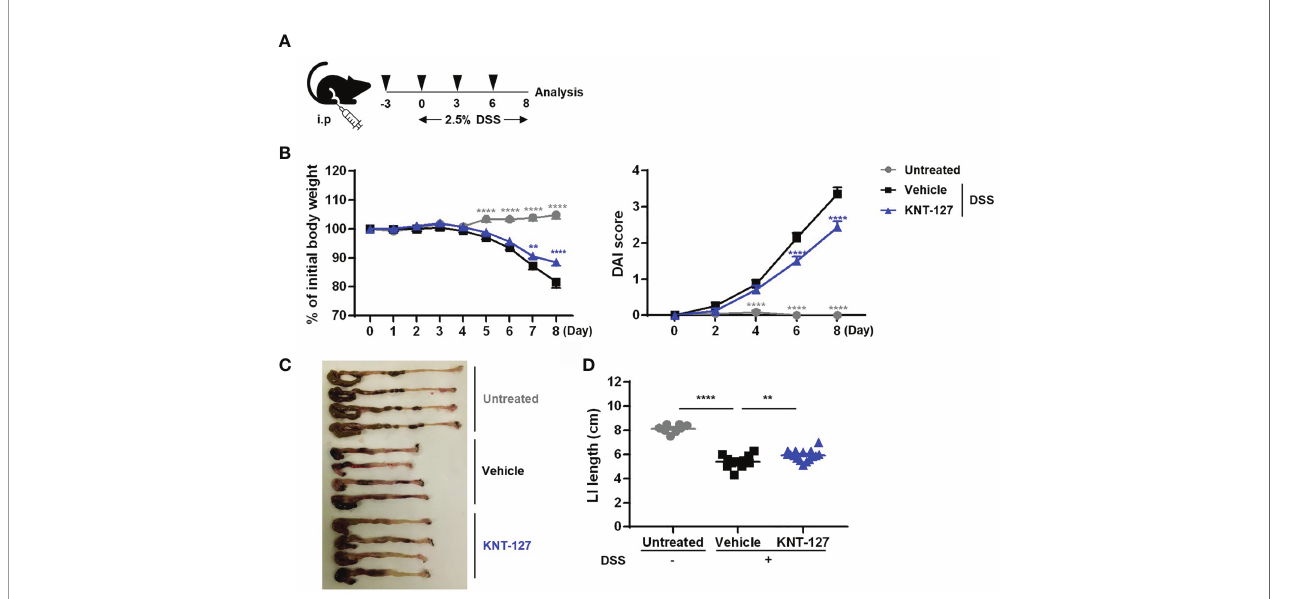
FIGURE 1 | Effects of KNT-127 on DSS-induced colitis. (A) Mice were given water containing 2.5% DSS to induce colitis starting on day 0, and 5 mg/kg KNT-127 (n=16) or vehicle (n=12) was administered intraperitoneally to the mice every 3 days from day -3 to day 6. Control mice (n=8) were given normal water. (B) The percentage of body weight to initial one (left). Disease activity index (DAI) scores (right). (C) Images of the colon and cecum on day 8. (D) Length of the large intestine. Symbol key: ○ , control; □ , vehicle; and △ , KNT-127. The data are shown as the mean ± s.e.m. ** P < 0.01; **** P < 0.0001 (one-way ANOVA followed by Dunnett ’ s multiple comparisons test, vs vehicle). i.p.,